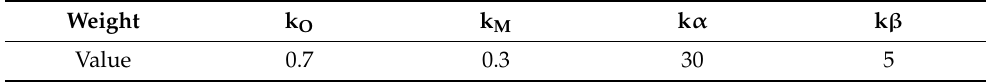
Table 3. Decision parameters of the dynamic lighting scheme.